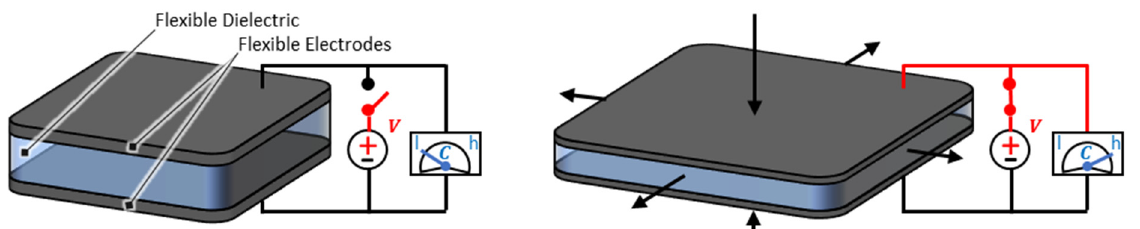
Figure 1. Schematic illustration of a DEA in the inactive state on the left, in comparison to the active state on the right.